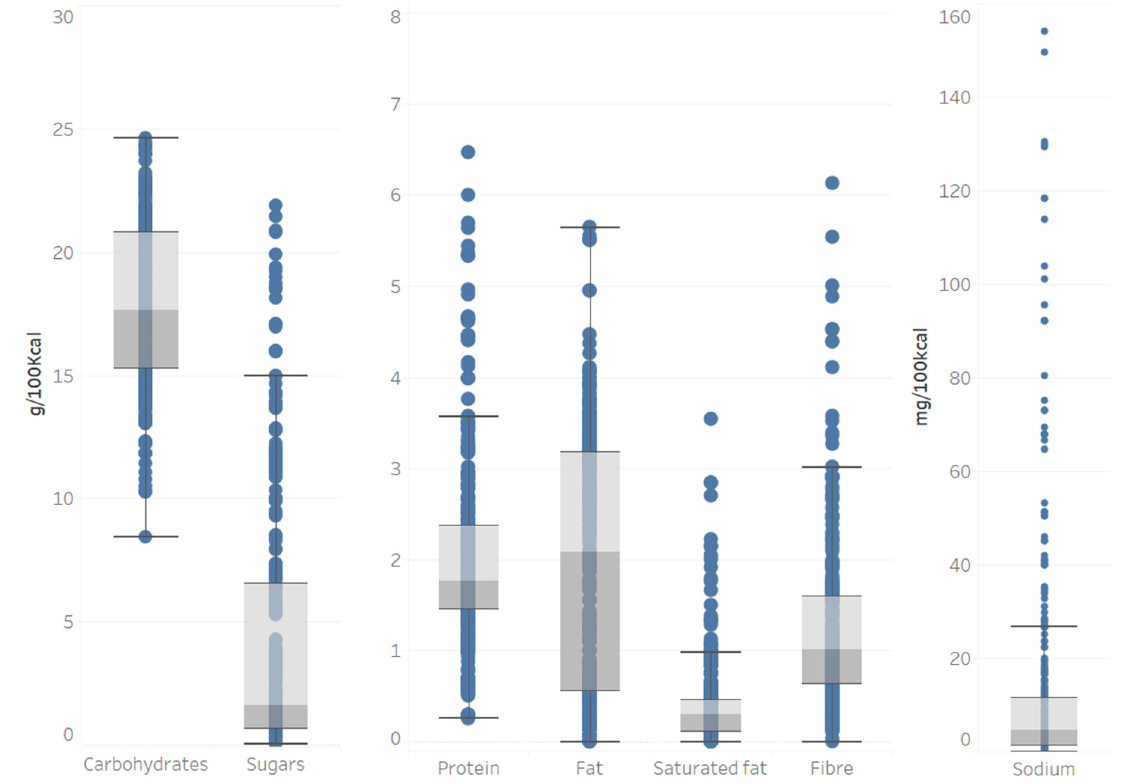
Figure A6. Nutrient content (g/100 kcal product, except for sodium mg/100 kcal product) of ‘Baby snacks’.